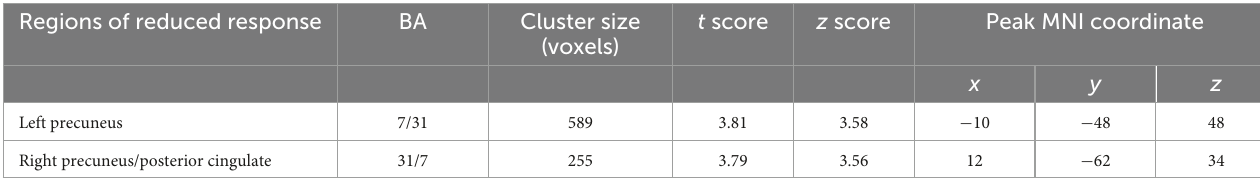
TABLE 3 Significant reductions in evoked brain responses to cutaneous heat pain in the PDM group (menstrual phase). Regions of reduced